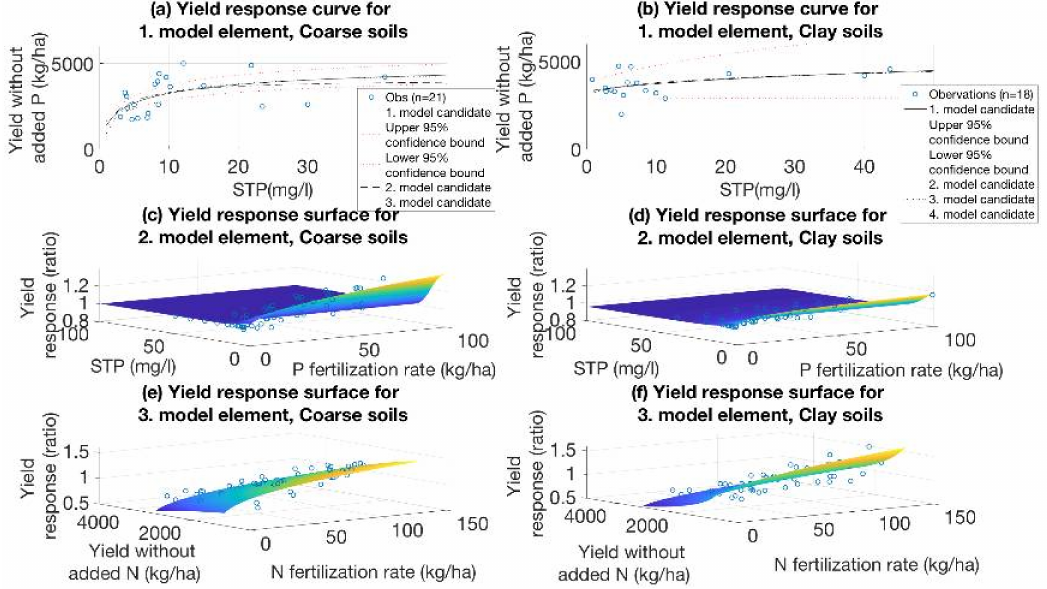
Figure A1. The data points and STP response curves for ( a ) coarse and ( b ) clay soils. The P response surfaces for ( c ) coarse and ( d ) clay soils, and the N response surfaces for ( e ) coarse and ( f ) clay soils provided by the best candidate models. For the third model element for clay soils, the random effects were set to their expected zero